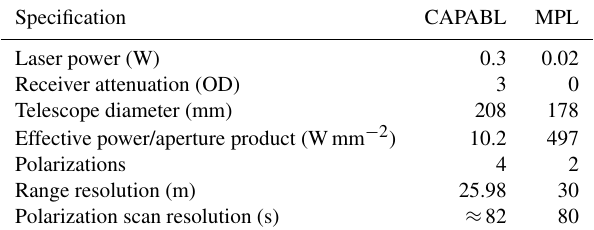
Table 3. Hardware comparison of relevant CAPABL and MP lidar specifications. The resolutions quoted are limited in range by the MPL afterpulse calibration data and in time by the CAPABL scan rate. The resolutions presented are as close as the data can be pro- cessed before linear interpolation of MPL data to CAPABL’s data grid. Effective power aperture product is reduced for CAPABL by the receiver attenuation by a factor of